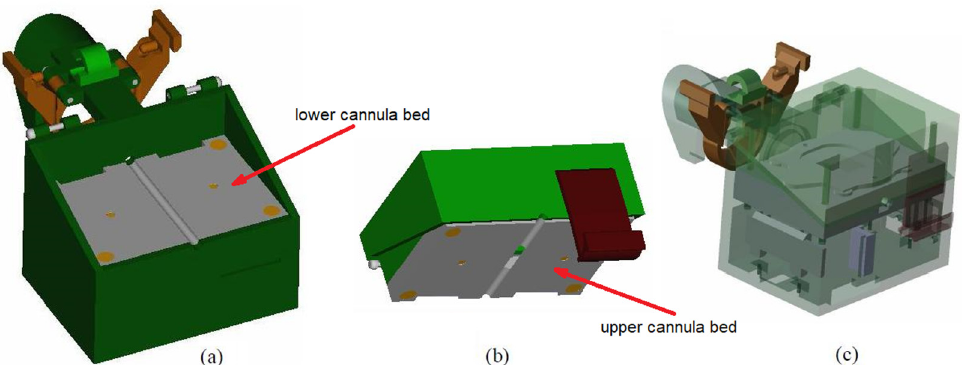
Figure 3. Details of the design of the housing unit of the D1 cannula displacement device: ( a ) the lower part, ( b ) the cover and ( c ) the assembly details. The grey parts in ( a , b ) are the lower and upper beds of the cannula. In the beds, both halves of the cannula guide channel are visible.